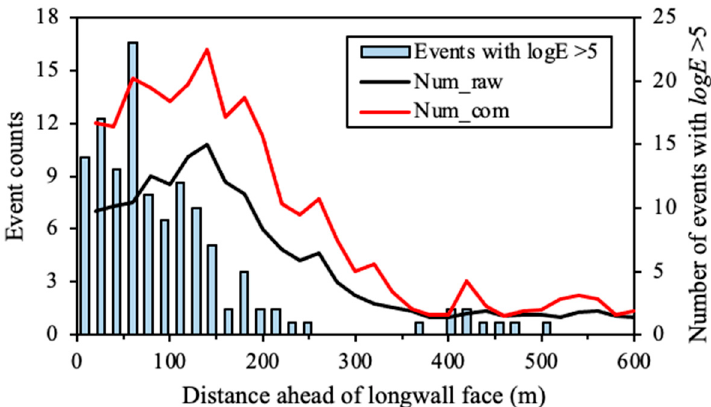
Figure 10. Distribution of average event counts ahead of the longwall face in LW250105 using the compensated seismic data ( 𝑁𝑢𝑚 𝑐𝑜𝑚 ) and raw seismic data ( 𝑁𝑢𝑚 𝑟𝑎𝑤 ).